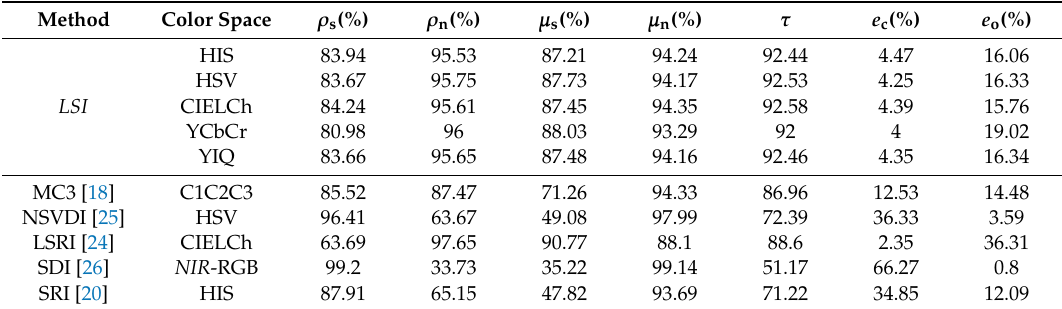
Table 1. Shadow detection accuracy measurements of various shadow detection algorithms for the test image Tripoli-1.